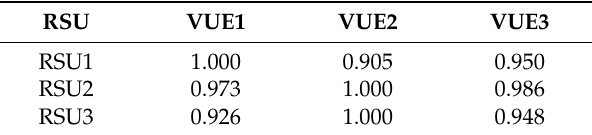
Table 4. The matching degree between RSUs and